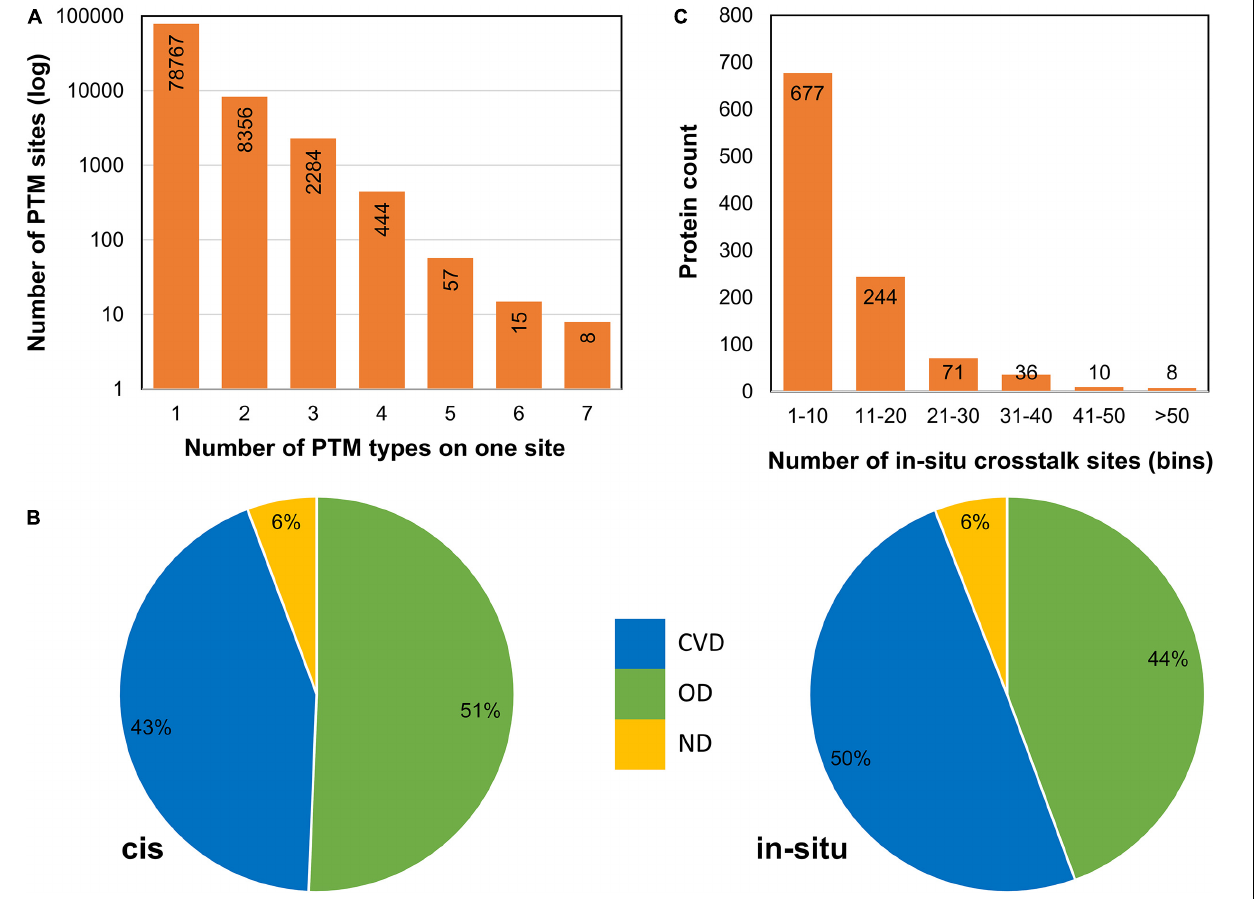
FIGURE 3 | Post-translational modification crosstalks in sirtuin interactor proteins. (A) The frequency of proteins with number of PTM types at each site. Apart from the first bar (with single PTM type), the rest have in situ crosstalks. (B) cis and in situ crosstalks for sirtuin interactors reveal that most crosstalks occur in CVDs and other diseases, whereas very few (only 6% sites) were not involved with any disease. The in situ crosstalk seems to play an important role in CVDs in sirtuin interactors. (C) The frequency of proteins in each bin of in situ crosstalk sites reveals that most proteins have 1–10 crosstalk sites. Few proteins have more than 50 such